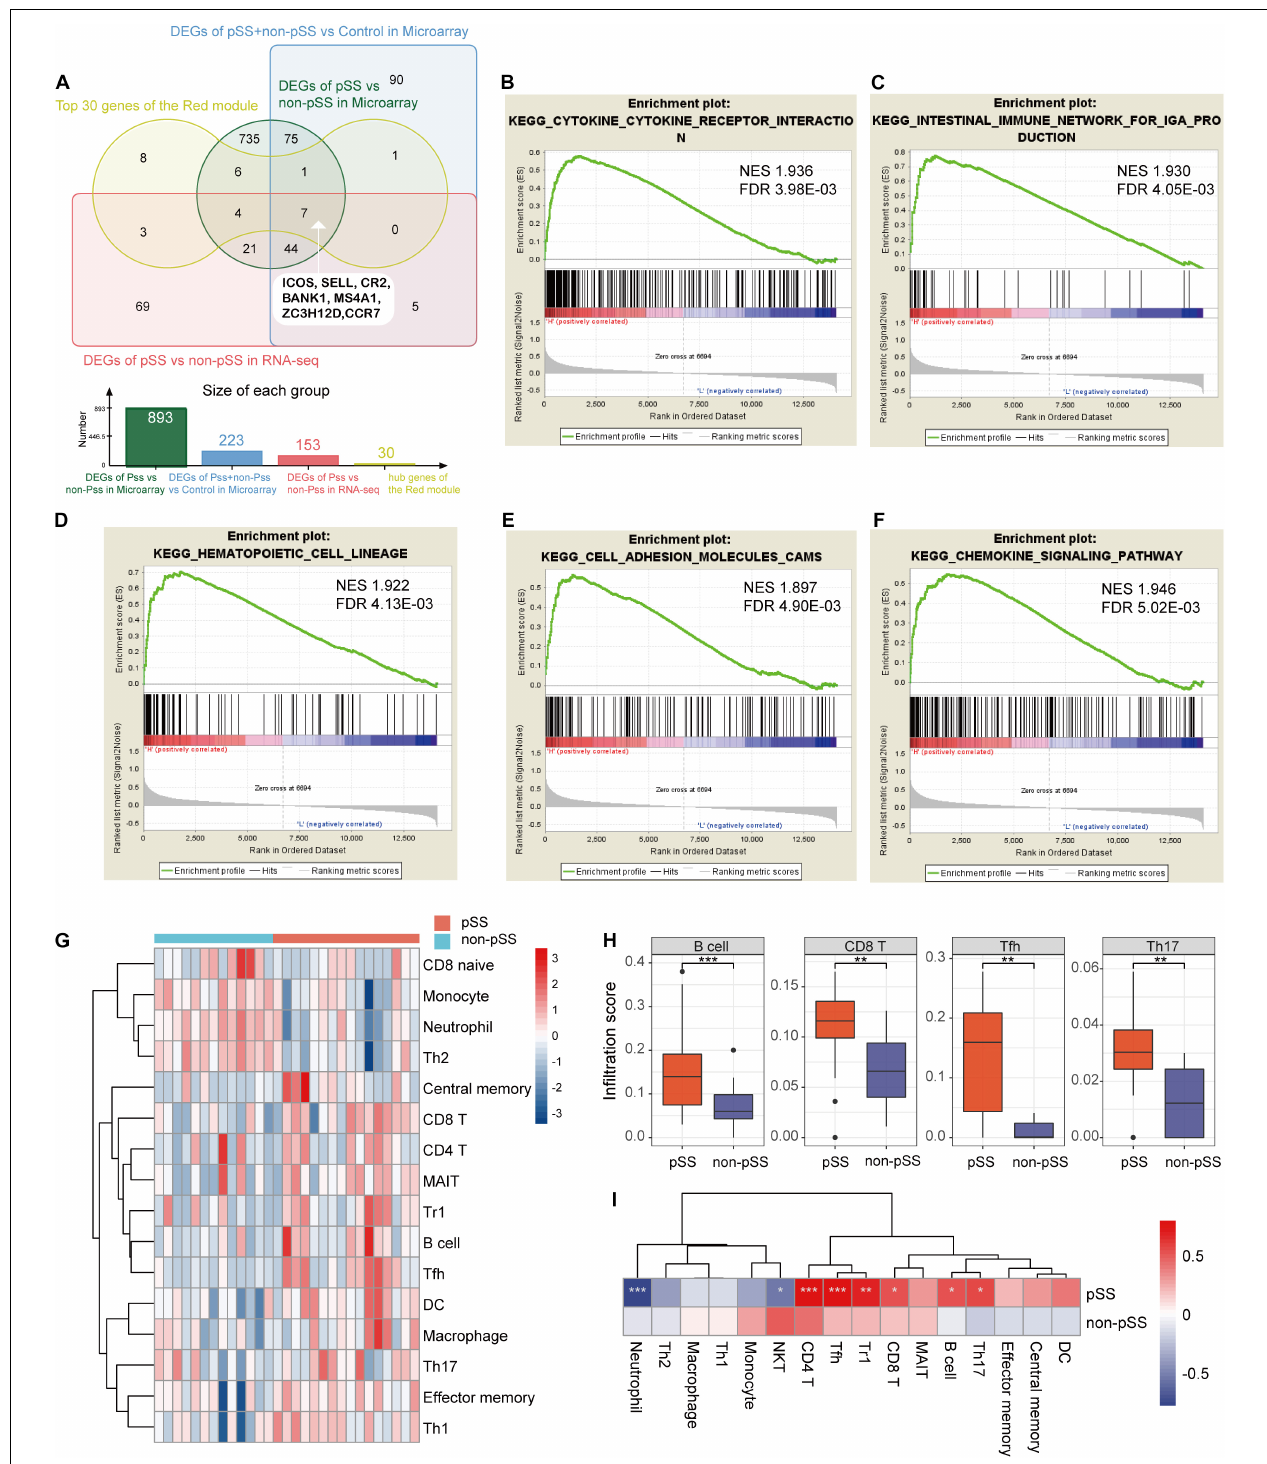
FIGURE 5 | The results of single-gene Gene Set Enrichment Analysis based on the expression of ICOS and immune cell infiltration. (A) Venn diagram showing the identification of seven hub genes combining common differentially expressed genes (DEGs) and the red module. (B–F) The elevated ICOS expression was enriched in cytokine–cytokine receptor interaction (B) , intestinal immune network for IgA production (C) , hematopoietic cell lineage (D) , cell adhesion molecules (E) , and chemokine signaling pathway (F) . (G) Heat map showing the different infiltration degrees of 24 immune cells in primary Sjögren’s syndrome (pSS) and non-pSS with infiltration scores. (H) Box plots showing the most significant difference of infiltration scores in B cells, CD8 + T cells, Tfh cells, and Th17 cells between pSS and non-pSS. (I) Heat map displaying the correlation of ICOS ’s expression and infiltration scores. * p < 0.05; ** p < 0.01; *** p < 0.001.